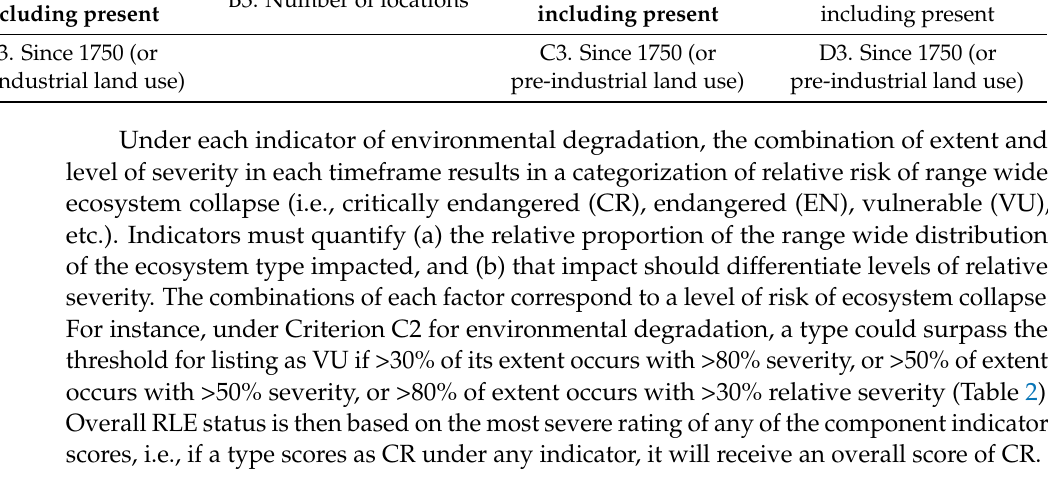
Table 2. Summary of indicator thresholds for scoring environmental degradation (C2) under the IUCN Framework for Red List of Ecosystems